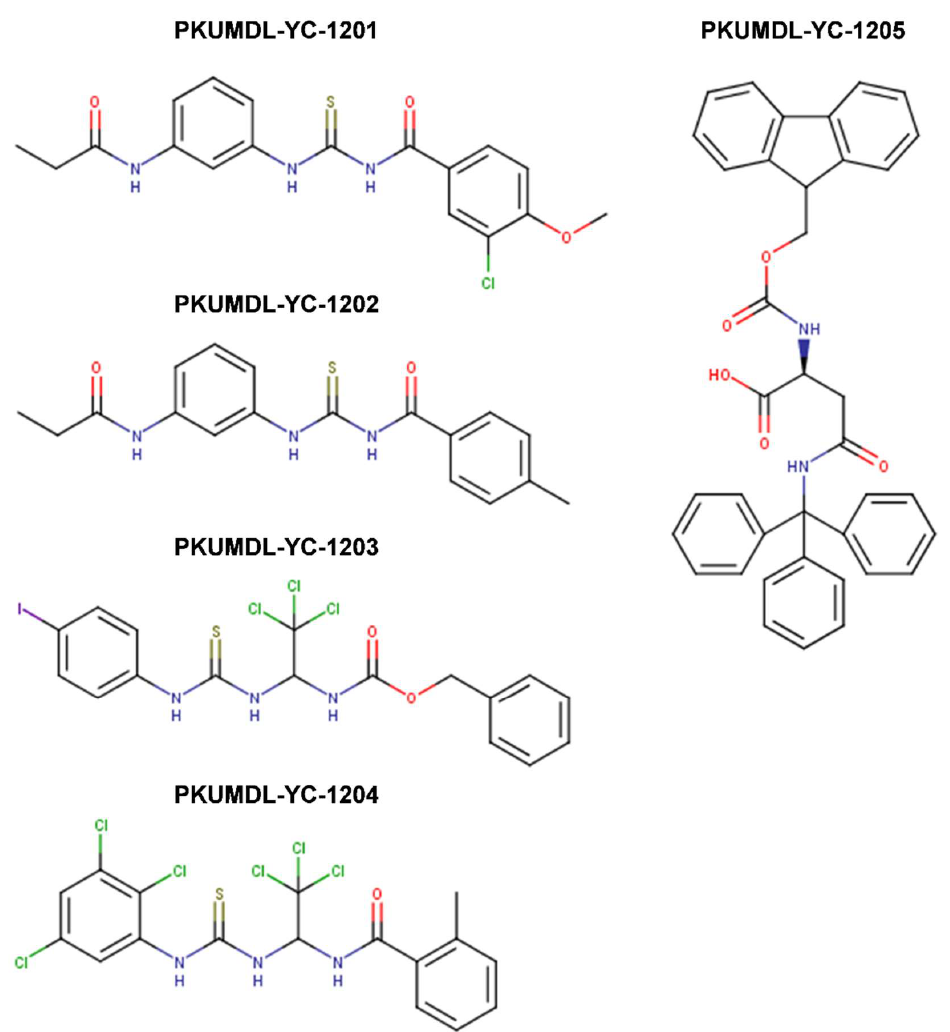
Figure 9. Chemical structures of PKUMDL-YC-1201 to -1205 compounds that disrupt Myc-Max dimerization identified through virtual screening (VS) multi-conformational docking against a reference ensemble of Myc disordered conformations generated through molecular dynamics (MD) simulations. Details are provided in the text.